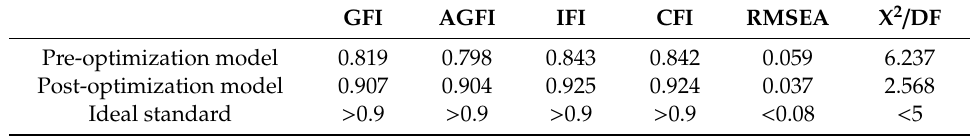
Table 1. Comparison of fit index before and after model optimization. GFI AGFI IFI CFI RMSEA X 2 / DF Pre-optimization model 0.819 0.798 0.843 0.842 6.237 Post-optimization